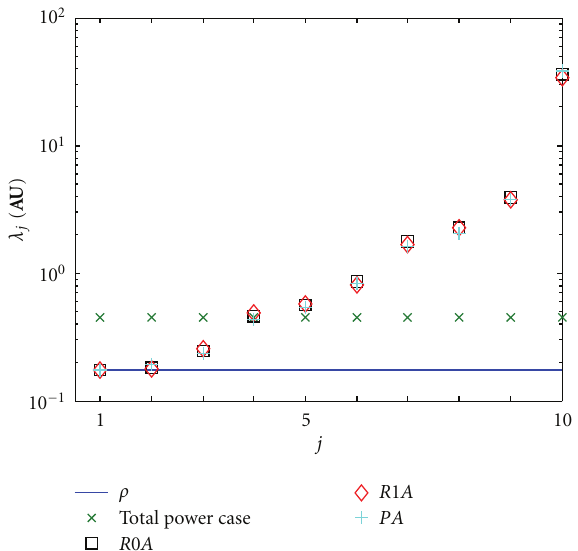
Figure 1: λ j ( AU ) as a function of j (the index of eigenvalues) when the upper bound in (8) is reached.